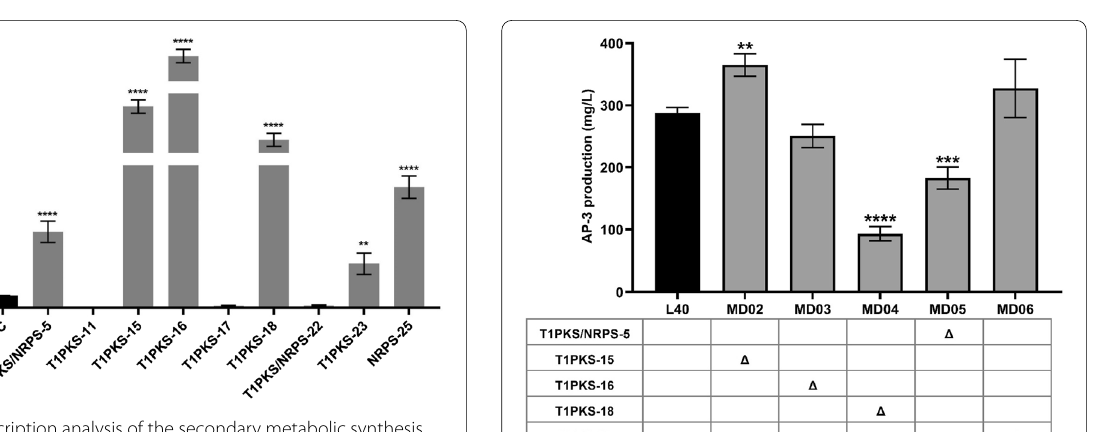
Fig. 6 Transcription analysis of the secondary metabolic synthesis gene cluster in strain L40. Transcription analysis of the putative gene Fig. 7 AP-3 production of mutants at the end of fermentation. L40, PKS clusters in strain L40. The 2 − ΔΔCt method was used to calculate the parent strain. MD02, mutant with T1PKS-15 deletion. MD03, the expression level, the average expression value of asmC is set mutant with T1PKS-16 deletion. MD04, mutant with T1PKS-18 to 1 as the standard. Fermentation experiments were performed deletion. MD05, mutant with T1PKS/NRPS-5 deletion. MD06, mutant three times. The values are means SD (standard deviation) of three ± with NRPS-25 deletion, as the negative control. The fermentation independent experiments. Significant differences were analyzed by experiments were performed for three times. The values are one-way ANOVA, and ** p < 0.01, **** p < 0.0001 means SD (standard deviations) of three independent experiments. ± Significant differences were analyzed by one-way ANOVA, and ** p < 0.01, *** p < 0.001, **** p <